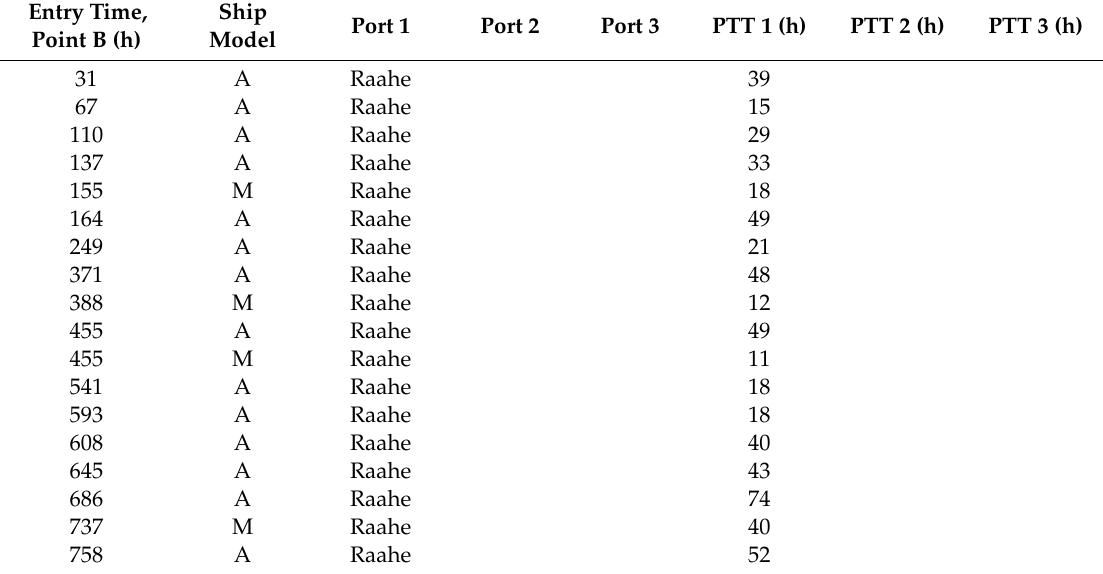
Table A2. List of ships arriving from northern Sweden (Point B as per Figure 4).